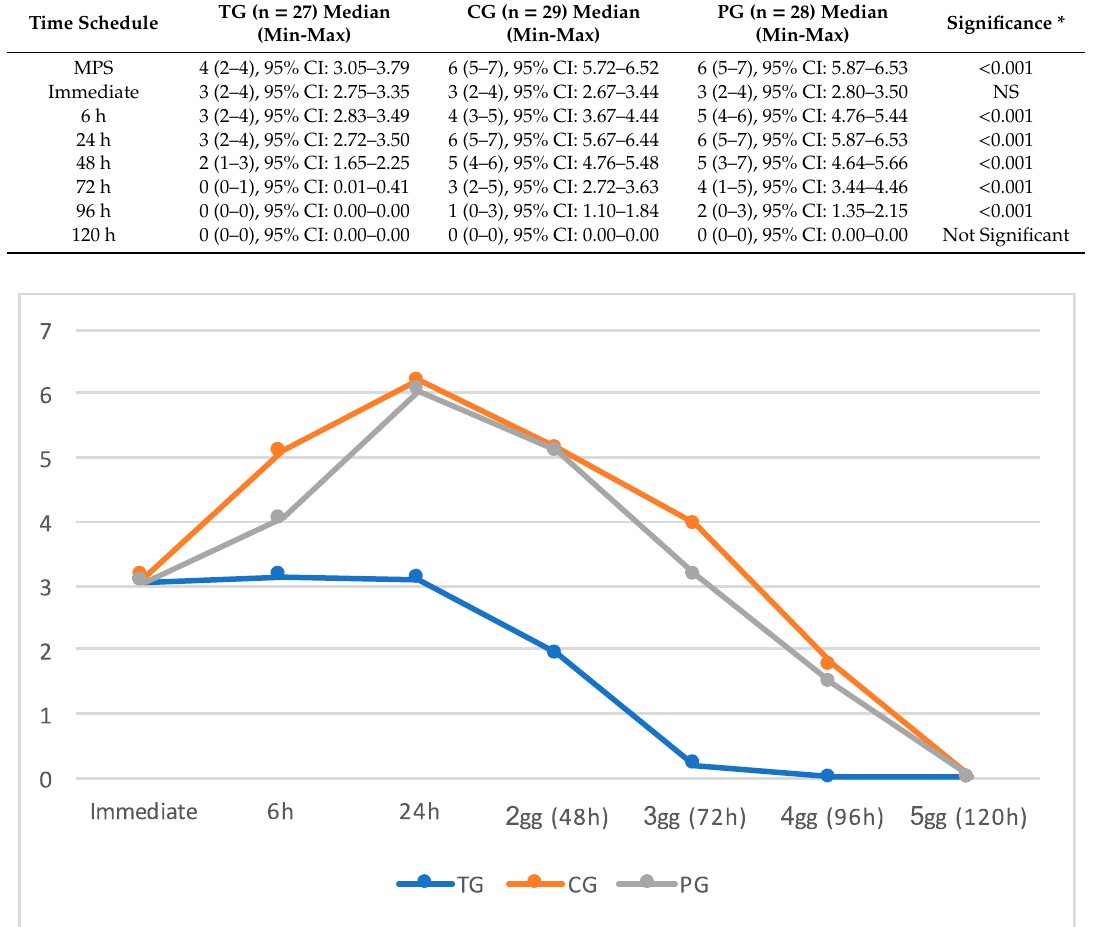
Figure 3. Graphic representation of the level of pain experienced at each time interval in both treatment group (TG), control group (CG), and placebo group